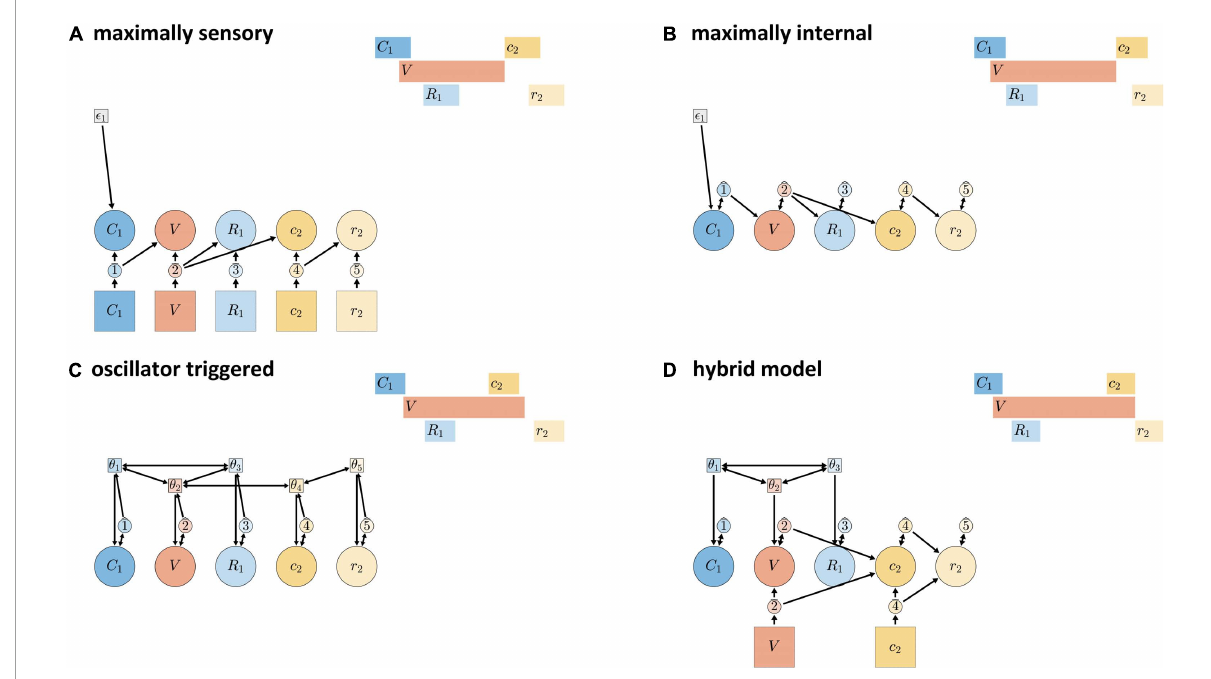
FIGURE9 Candidate models of CVC syllables. (A) Maximally sensory model where all activation and deactivation is controlled by external sensory feedback. (B) Maximally internal model where all control is governed by internal feedback. (C) Fully oscillator-triggered model where all gestures are initiated by oscillators. (D) Hybrid model in which pre-vocalic gestural activation is oscillator-governed while post-vocalic activation is governed by either internal or external